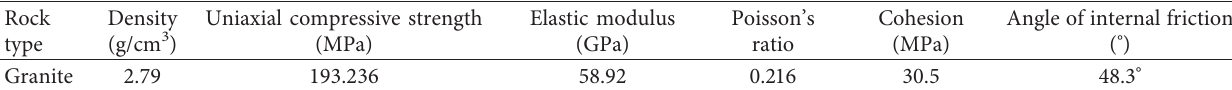
Table 3: Test results of the physical and mechanical parameters of granite.